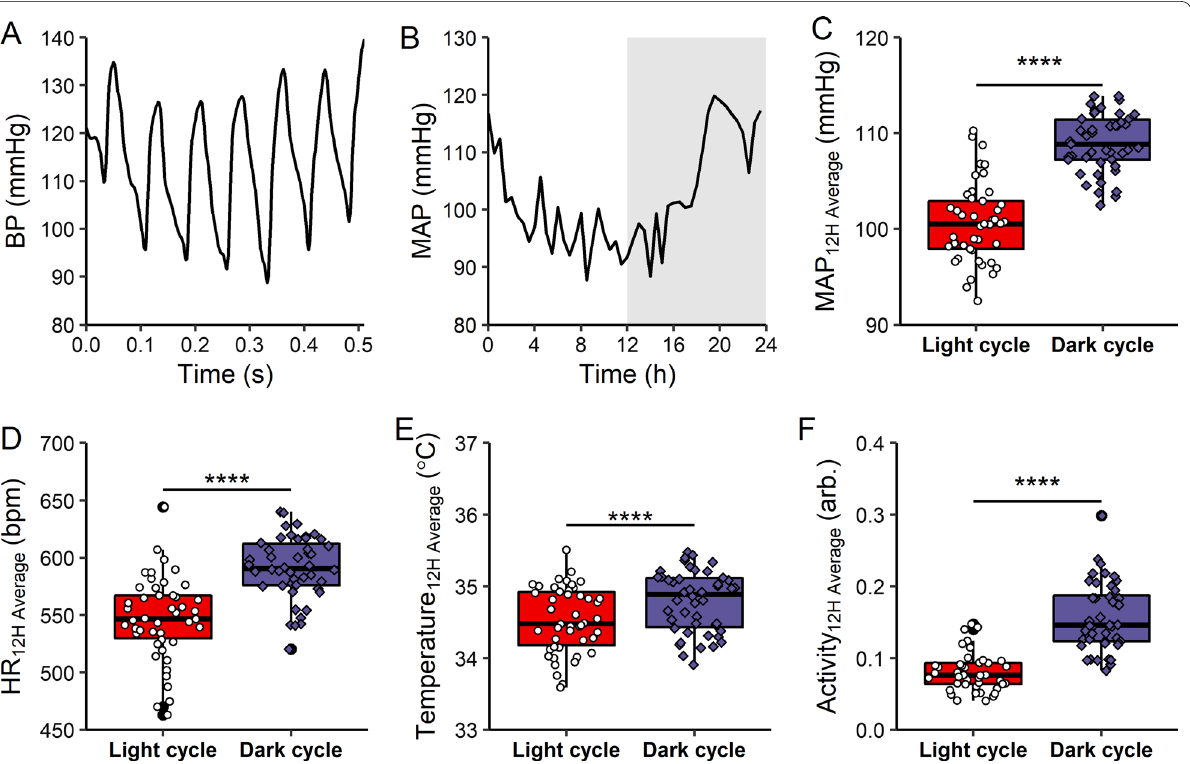
Fig. 1 Telemetry system for analyzing short‑term and long‑term changes in blood pressure. A representative blood pressure wave tracing from a single telemeter‑implanted mouse. BP is measured at 500 Hz. B representative 24 h tracing of MAP using the same telemeter system. From the blood pressure wave, MAP is calculated every 10 s. These 10 s bins are averaged over 30 min. Gray background indicates dark cycle when mice are active. C average normotensive MAP, D average normotensive HR, E average normotensive body temperature and F average normotensive activity. MAP, HR, temperature and activity are analyzed during 12 h of dark cycle and light cycle. Data are represented as individual mouse data points with mean SEM. n 44, ****p < 0.0001, paired ± =